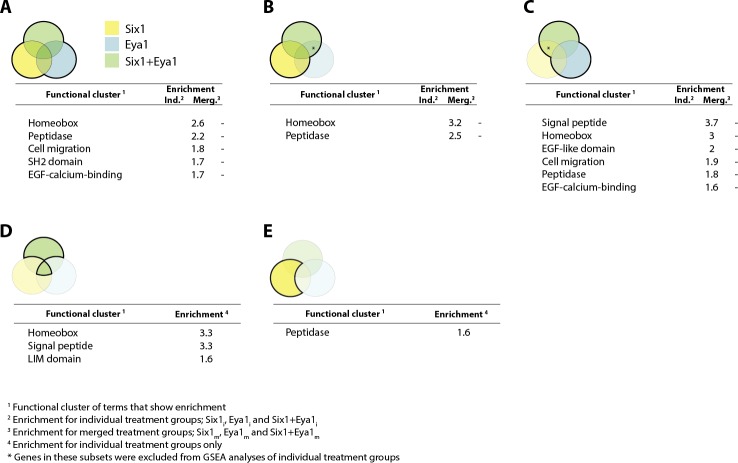
Gene set enrichment analysis (GSEA) showing enriched clusters of functional terms for down-regulated genes in different treatment groups.In each case, treatment groups considered are highlighted and outlined in bold in the accompanying Venn diagram. Yellow colouring indicates Six1 treatment; blue shows Eya1 and green Six1+Eya1. Enrichment scores ≥1.5 are reported for individual treatment groups (Ind.) and, where available, ≥0.5 for merged treatment groups (Merg.). (A) Down-regulated genes from all treatment groups included in analysis; (B) Six1 overexpression only; (C) Eya1 overexpression only. (D) Genes differentially expressed after overexpression of both Six1 and Eya1; (E) exclusively after Six1 overexpression.